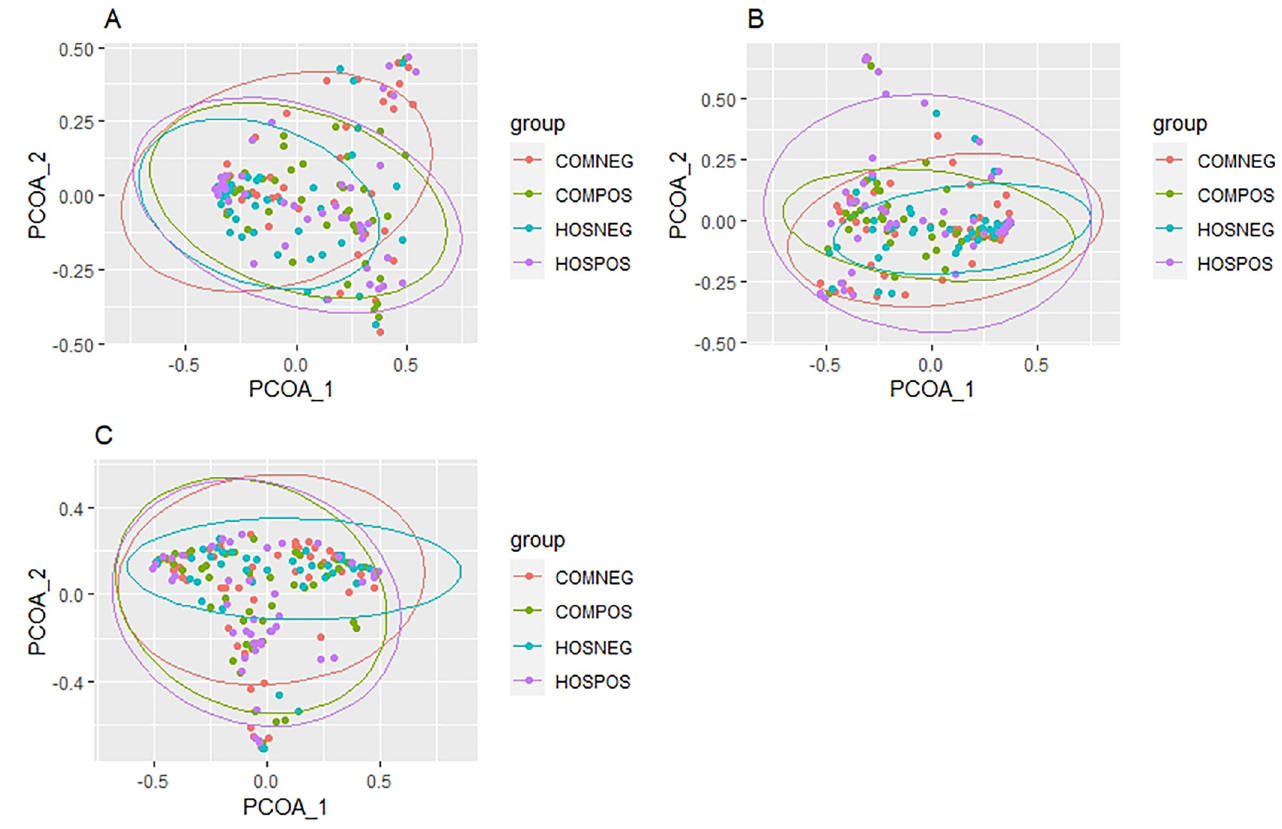
Fig 2. Beta diversity differences. Principle coordinates analysis plots based on Bray-Curtis dissimilarity among our four study groups at the A. species, B. genus, and C. family taxonomic ranks. P-values were derived from PERMANOVA. 95% confidence ellipses are displayed around each study group. (Fig 4). ALDEx2 revealed significant differences (Kruskal-Wallis p < 0.05) in Streptococcus